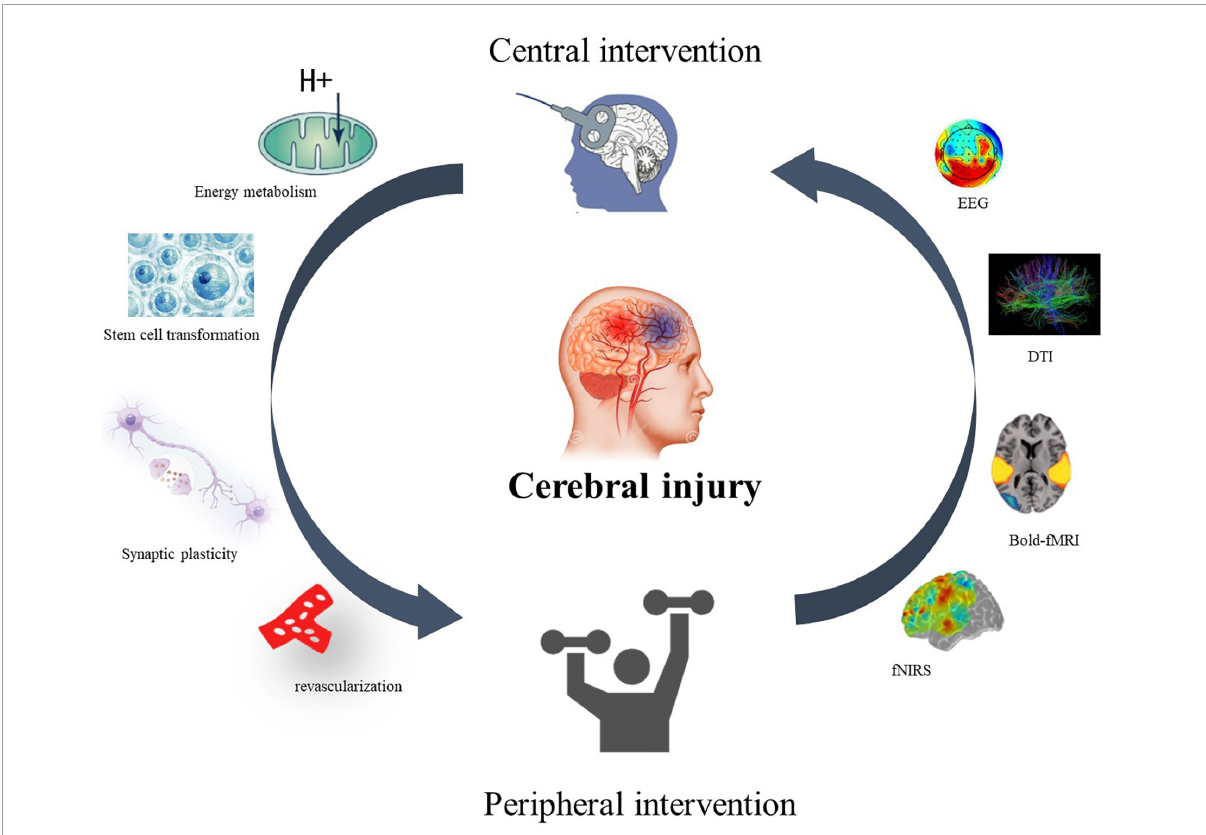
FIGURE1 Closed-loop rehabilitation theory. A central–peripheral closed-loop intervention model for motor dysfunction after stroke. The therapeutic effect and mechanism can be reflected by EEG, neuroimaging, cerebral blood oxygen content, synaptic remodeling, energy metabolism, and stem cell